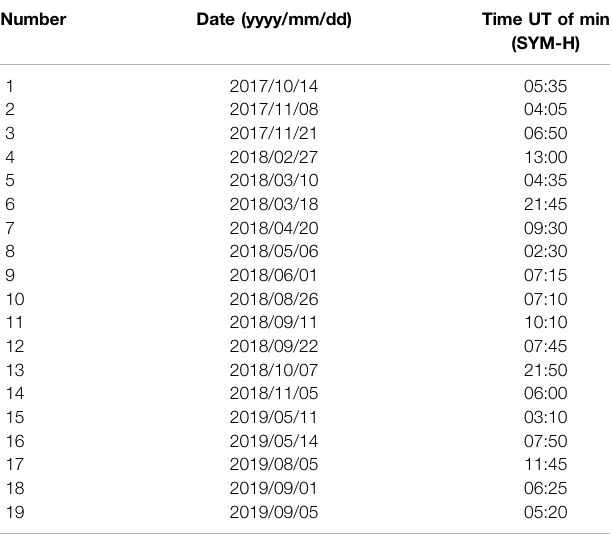
TABLE 1 | Additional list of geomagnetic storms in October 2017 — September 2019 used in this study (storms before October 2017 are listed in Turner et al. (2019) (their Table